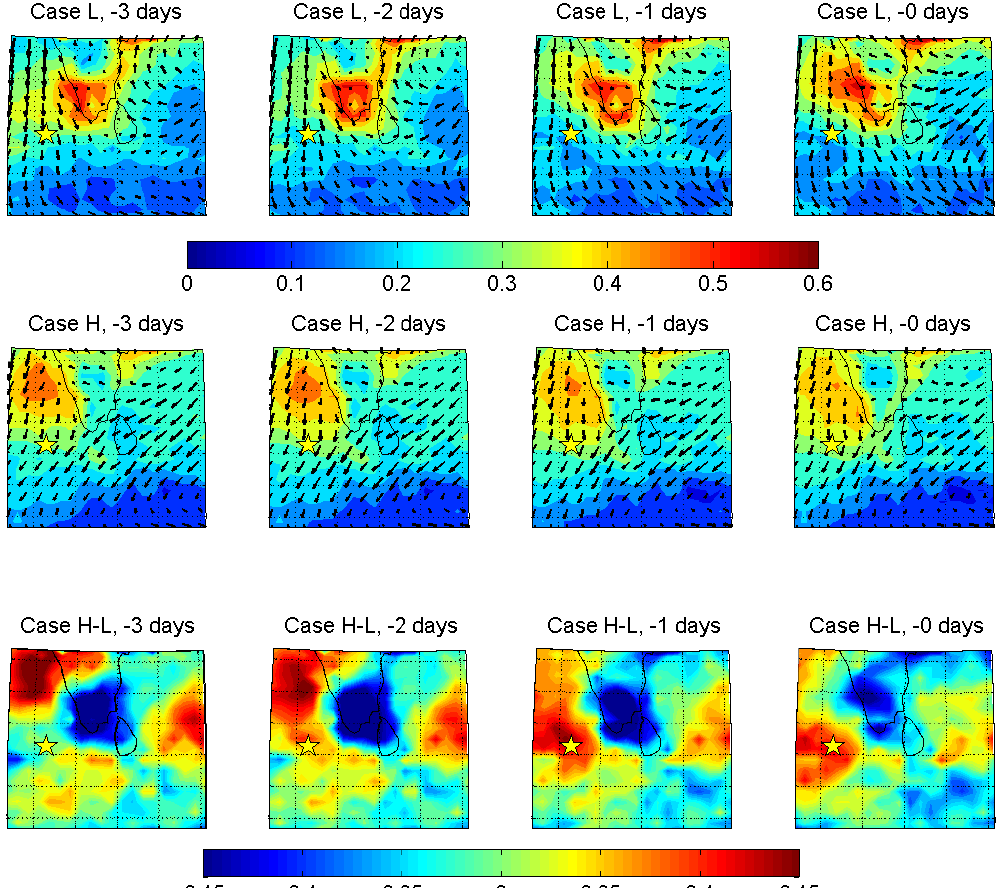
Figure A6. Average daily MODIS AOD for (top row) Case L, (middle row) Case H, and (bottom row) the difference between the two. Note that this includes all Case L and Case H days as identified in Table 1, rather than solely the ones on which a UAV was flown. The color scale shown is the same for both Case L and Case H, and the location of MCOH is indicated by the yellow star. From left to right, the columns are 0, 1, 2, or 3 days prior to a given classification. Note that while Case H corresponds to higher AOD over MCOH, Case L sees higher AOD over the Indian subcontinent. In Case H, the air mass of high aerosol concentration is seen to move south-southeastward to arrive over MCOH. This corresponds to the HYSPLIT and ECMWF low-level trajectories, indicating that upper-level pollution transport is not dominant in these cases. The arrows overlaid on the top two rows indicate the ECMWF average wind fields at 1000hPa, showing similar north-northwesterly flow approaching MCOH in both cases. With increasing altitude, the wind can be seen to change to a northeasterly direction around the 850hPa level, although this change occurs lower in altitude for Case H ( ∼ 900 vs. ∼